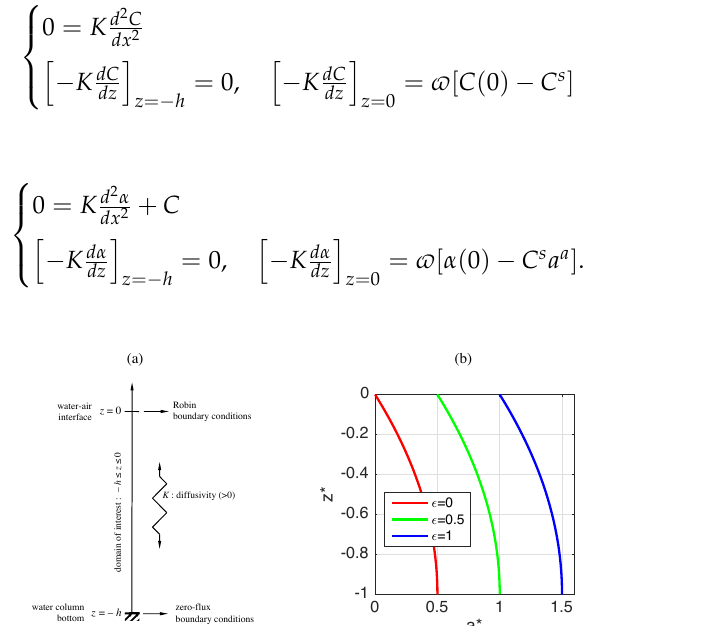
Figure 8. Schematic representation of the vertical, one-dimensional domain of interest dealt with in Section 3.6 ( − h ≤ z ≤ 0) (panel ( a )), and age (60) of the dissolved gas originating from the atmosphere for various values of dimensionless parameter (cid:101) (panel ( b )). The lower boundary ( z = − h ) is impermeable. Robin boundary conditions, related to gas exchanges, are prescribed at the water–air interface ( z = 0). Dimensionless variables are represented in panel ( b ). They are identified by asterisks and are defined as follows: z ∗ = z / h and a ∗ = K ( a − a a ) / h 2